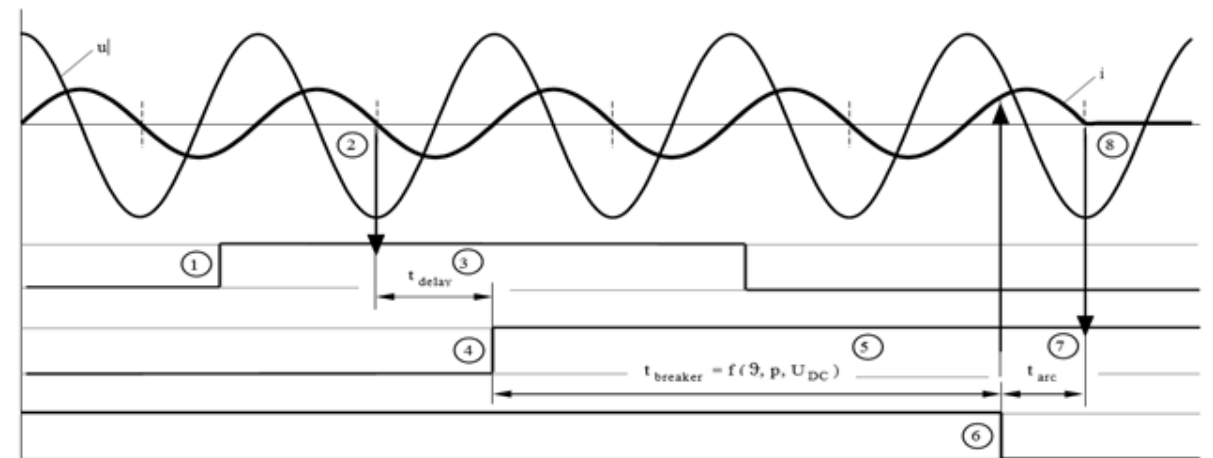
Figure 6. Disconnecting operation of circuit breaker with a control system: 1—disconnected command, 2—identify the zero point of the current, 3—delay time, 4—command to the breaker disconnected coil, 5—disconnected time, 6—separate contacts; 7—arc time, 8—end of the current flow.